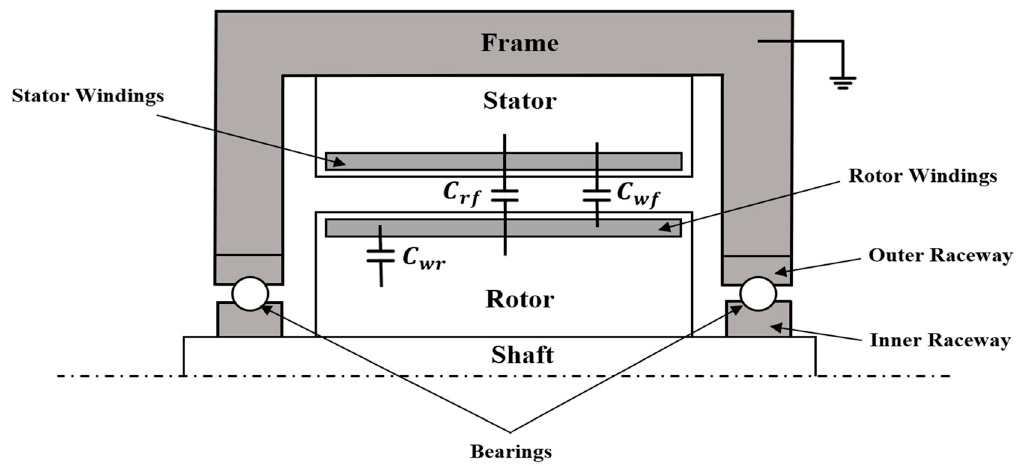
Figure 1. Three-phase pulse-width modulated power converter connecting rotor winding to power grid.